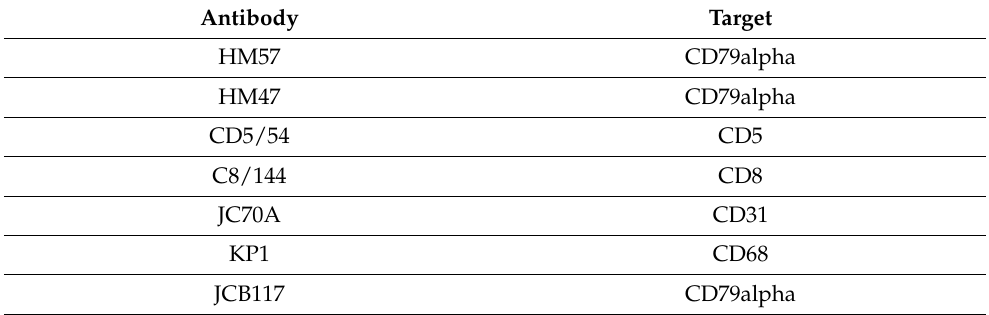
Table 2. Antibodies generated from peptide antigens that become useful diagnostic reagents.